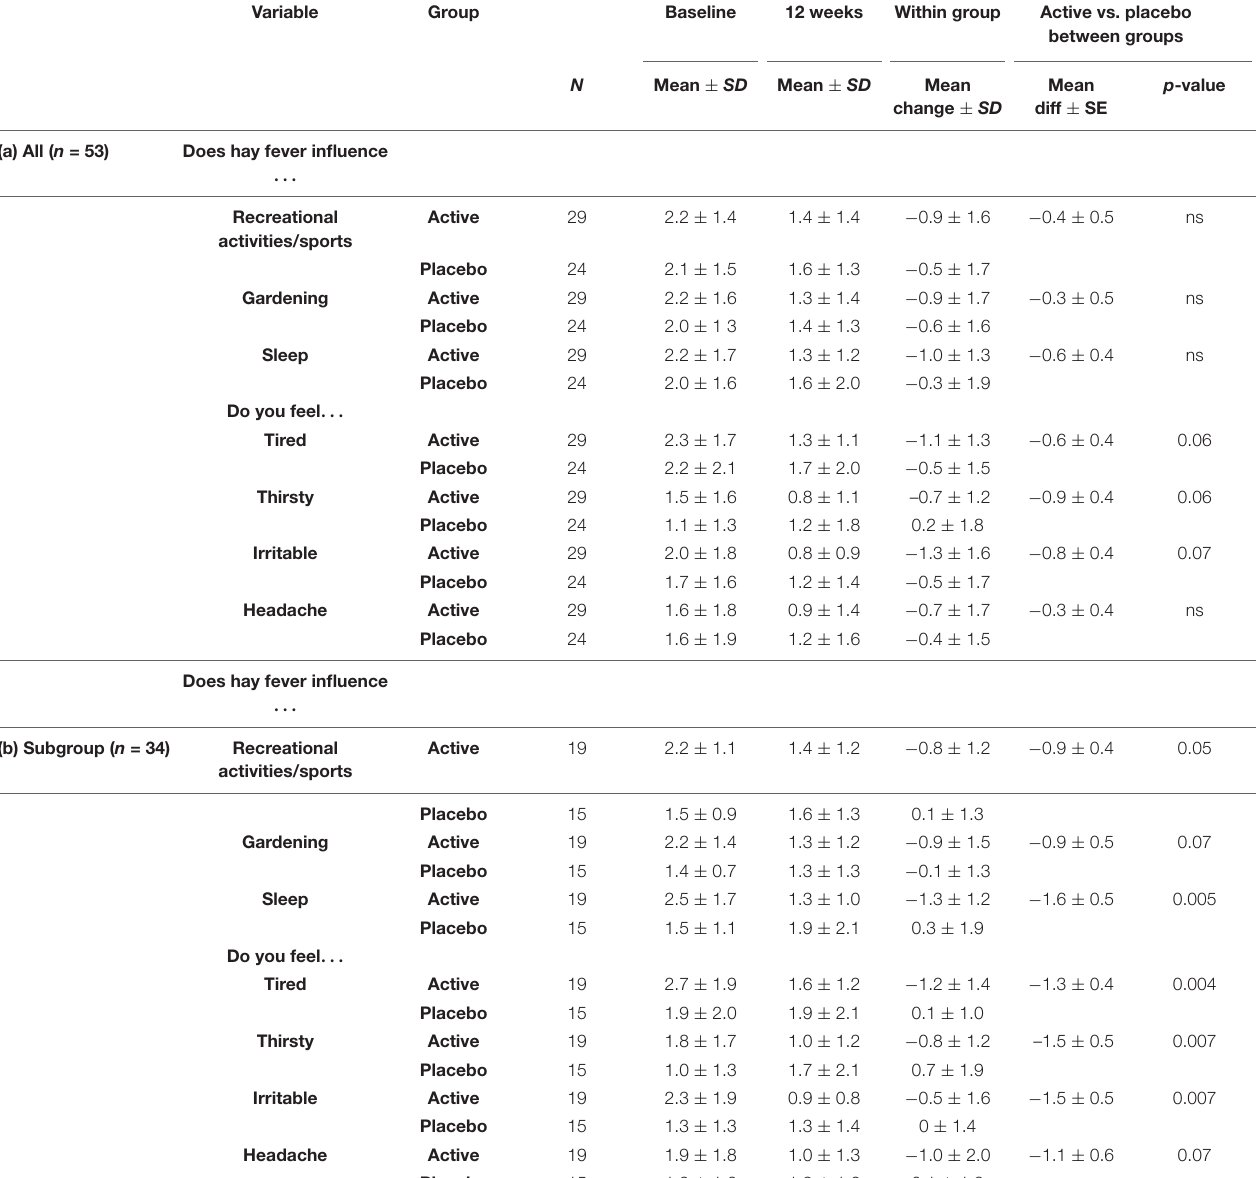
Variable Group Baseline 12 weeks Within group Active vs. placebo